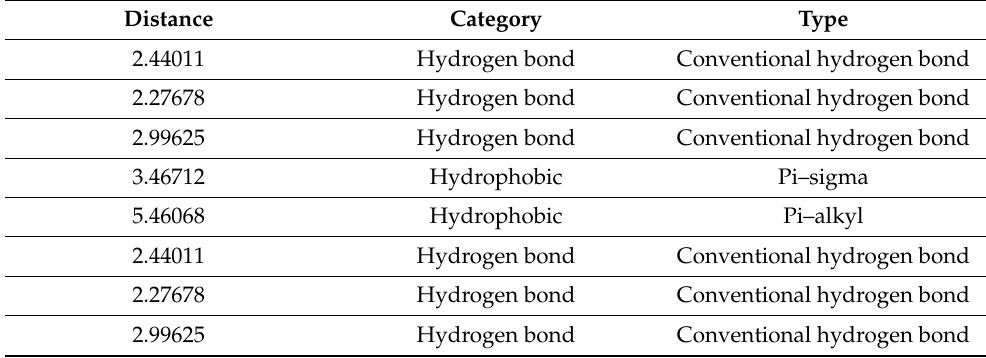
Table 1. Types of bonds for curcumin–GMS